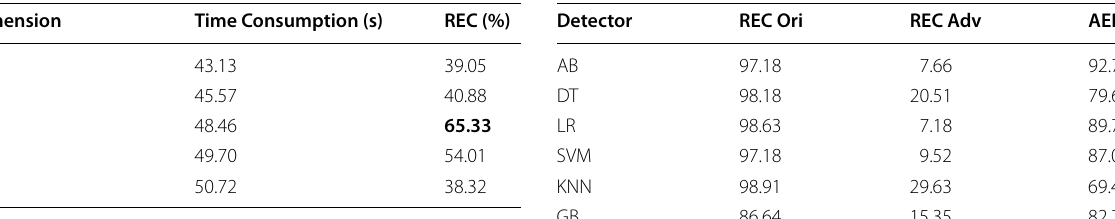
Table 9 The time consumption and REC of different API dimension